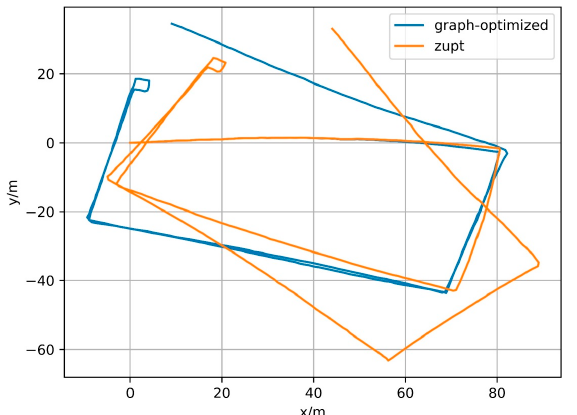
Figure 22. Result of Path C.